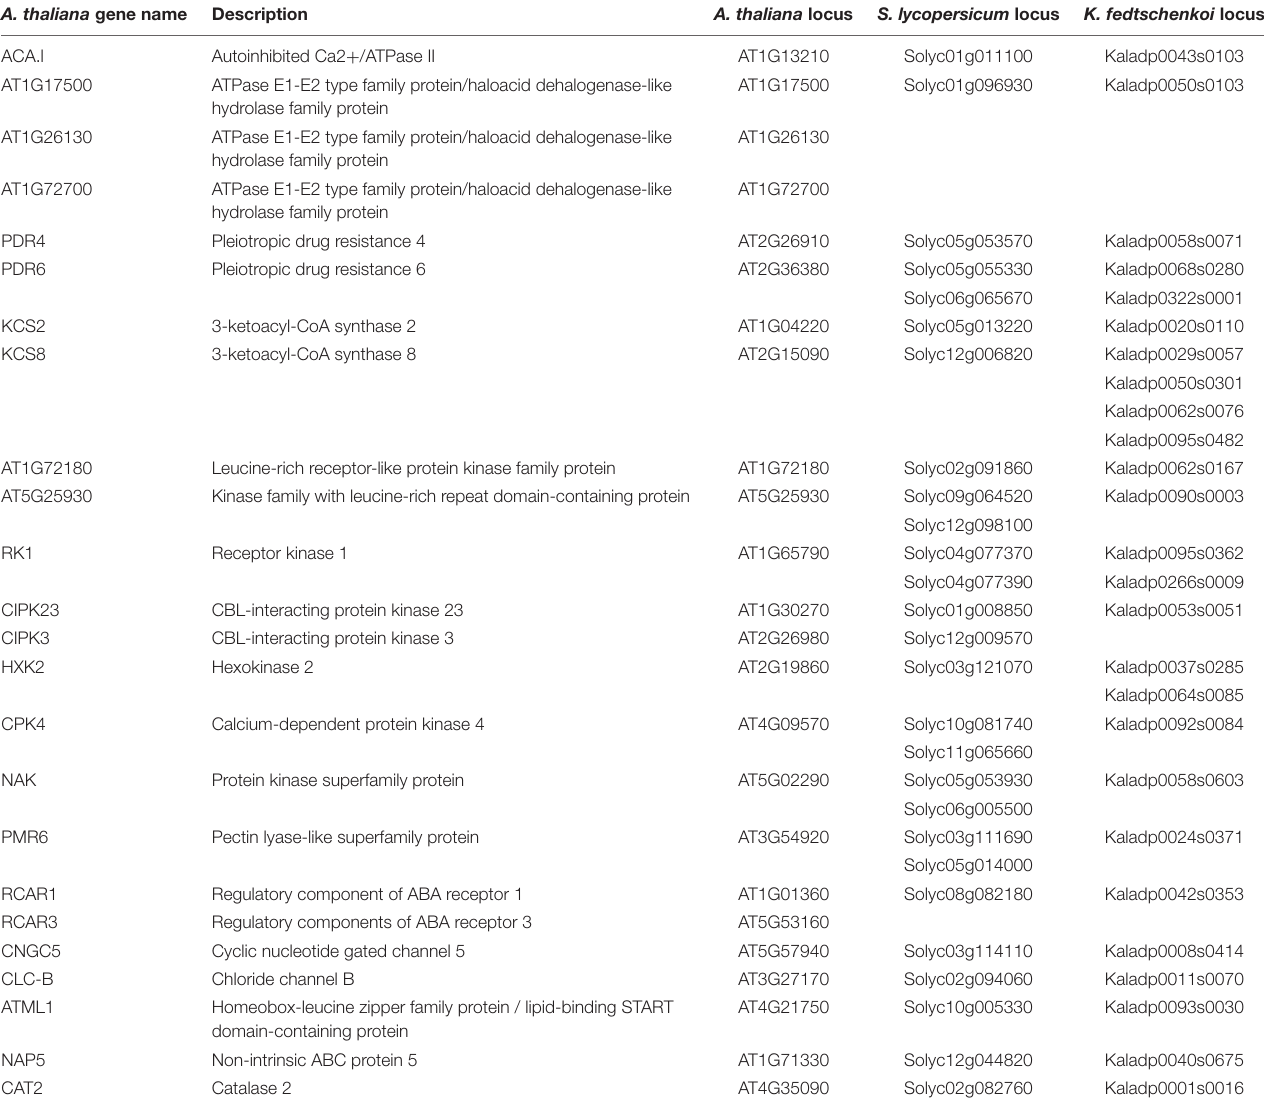
TABLE 2 | Orthologous genes in Arabidopsis thaliana , Solanum lycopersicum , and Kalanchoë fedtschenkoi that displayed differential enrichment between dusk and dawn in gene